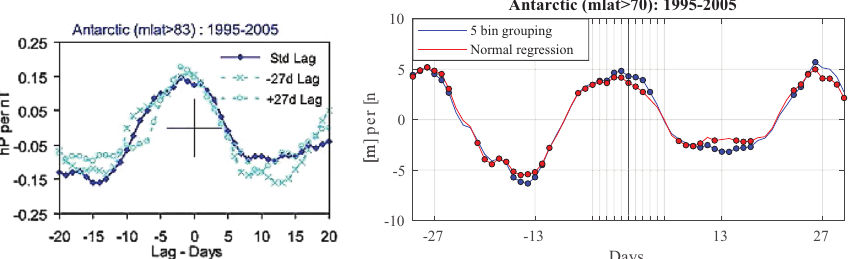
Fig. 4. Left panel : A copy of the upper panel of Figure 2 in B2008. The fi gure illustrates calculated regression coef fi cients showing lead – lag variations of D p at mlat >83 (cid:3) S. It shows three cycles of IMF B y , where the dark blue line represents the regression coef fi cients without any lag, while x and o cyan lines represent a (cid:1) 27 and +27 day lag between IMF B y and D p data series. All maxima in D p are seen to occur (cid:1) 2 days before the peak in the IMF driver, which occurs at day 0. Right panel : Lead – lag variations of D Z g at mlat >70 (cid:3) S. The blue line is the calculated regression coef fi cients showing lead – lags when the fi ve bin method by B2008 is used. The red line is the regression coef fi cients showing lead – lag variations when regression is done without the initial grouping. Negative days (leads) represent D Z g occurring before the B y component, and positive days B y occurring before D Z g . Dots indicate signi fi cance at the 95% level for the regression coef fi cients calculated by Student ’ s t -test. The upper panel of Figure 2 in B2008 is reproduced with permission from John Wiley and Sons.